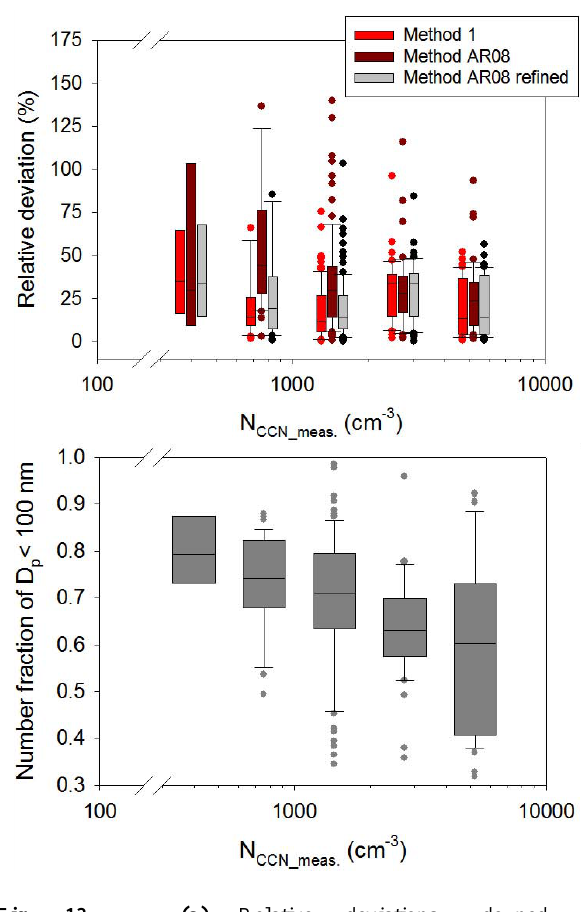
Fig. 13. (a) Relative deviations, defined as | /N | N CCN meas , for methods 1 and 4, CCN pred N CCN meas and (b) the number fraction of particles smaller than 100nm D p for each NCCN bin. The schematic plots are drawn in the same manner as explained in Fig.